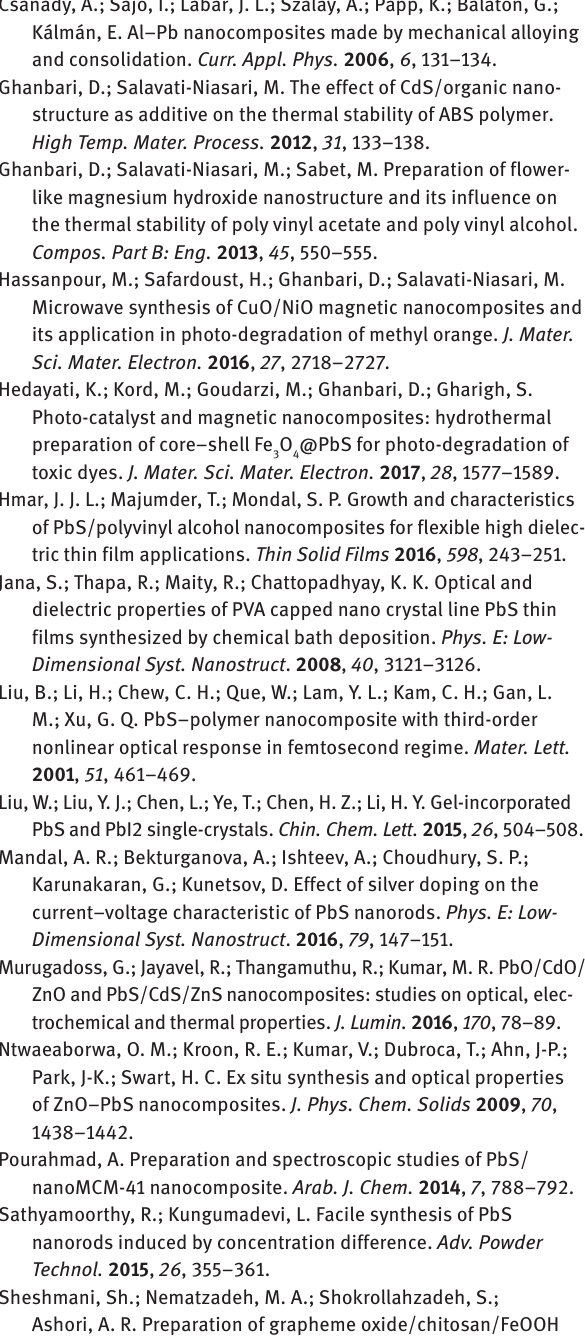
Sugars were used as green, safe, cost-effective, and bio- compatible capping agents. The XRD pattern of PbS shows the patterns of pure hexagonal phase. The SEM image shows the PbS synthesis with glucose agglomerated nanoparticles.